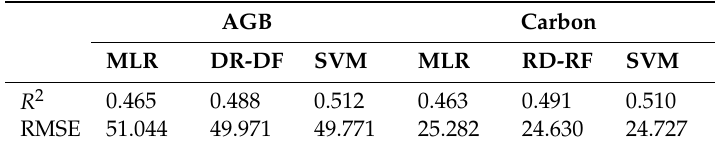
Table 4. Summary of the goodness-of-fit statistics for each machine learning method using 10-fold cross-validations for AGB and carbon content. The best results are highlighted in bold